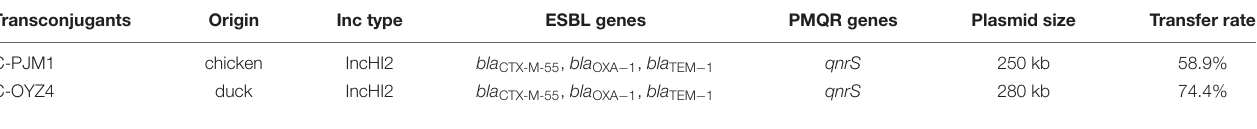
TABLE 2 | Characteristics of bla CTX - M - 55 gene-positive